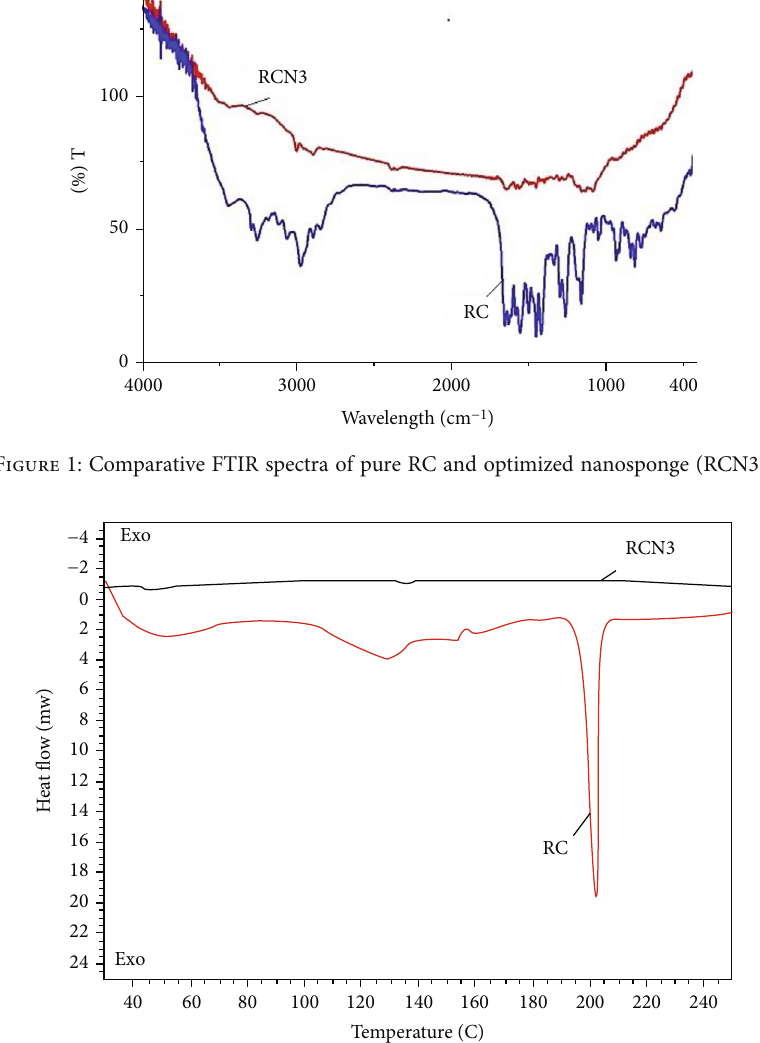
Figure 2: Comparative DSC spectra of pure RC and optimized nanosponge